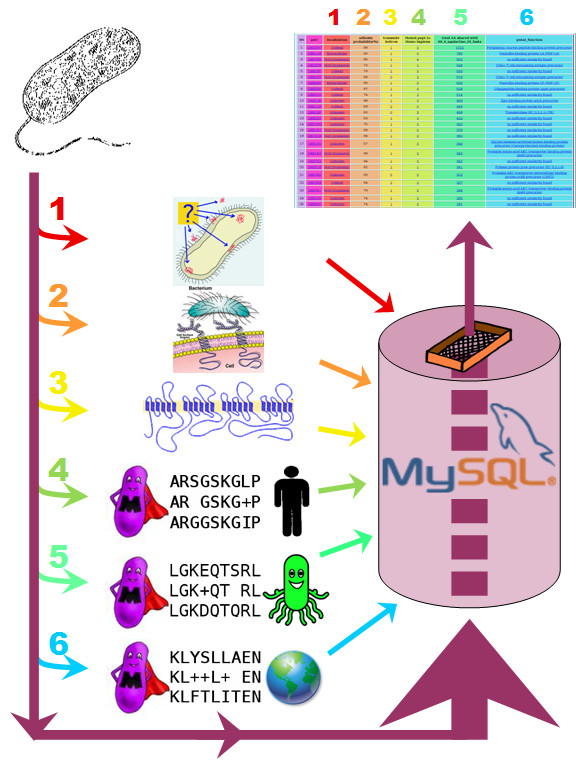
Flow-chart of NERVE working process. Amino acid sequences from the whole bacterial proteome undergo six analytical steps: prediction of subcellular localization (1), calculation of probability of being adhesin (2), identification of TM domains (3), comparison to the proteome of Homo sapiens (4) and to that of a pathogen selected by the user (5), assignment of a putative function (6). Each of these steps stores data mined in an SQL database. After filtering and ranking, the best VCs are presented in a user-friendly html table (see figure 1 and Results and Discussion for details).